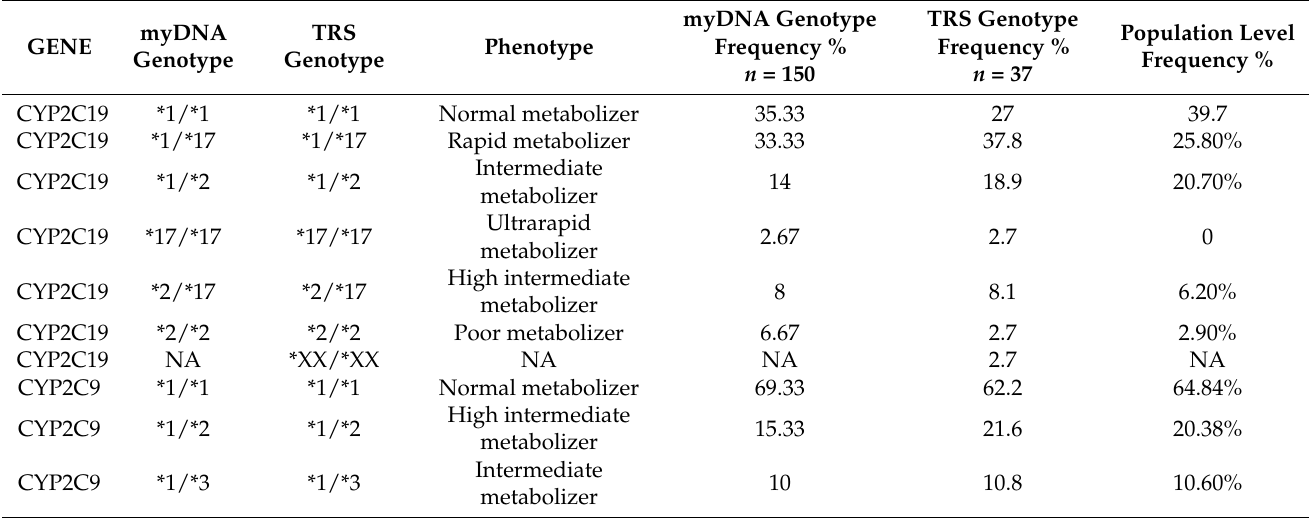
Table 3. Sample of a table comparing the frequency of myDNA calls and Kailos calls to population averages of those genotypes. Full table contains 62 genetic variations. See Appendix A.